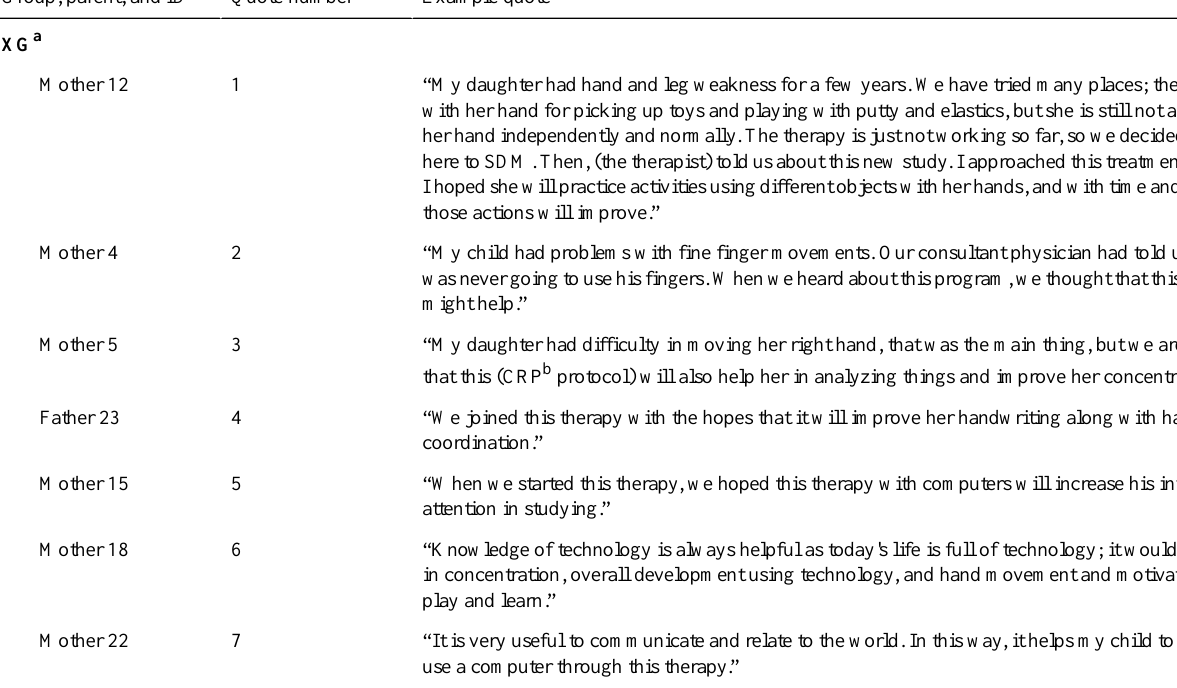
Example quoteQuote numberGroup, parent, and ID